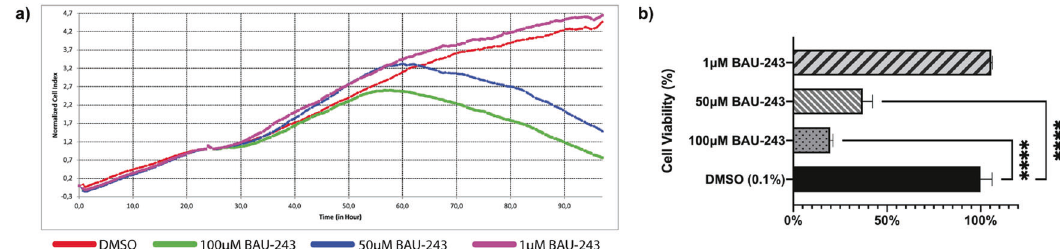
Fig. 1 BAU-243 inhibited GBM cell proliferation. a Normalized cell index of A172 cells treated with DMSO (0.1%), 100 µM, 50 µM, and 1 µM BAU-243. Electrical impedance measurements were taken every 15 min for 96 h. Treatment was done at 24 h after cell seeding. b Percentage cell viability of A172 cells treated with BAU-243. DMSO treated group was accepted as 100%, and cell viability of each condition after treatment at 24, 48, and 72 h were normalized to the DMSO control group. Data are expressed as mean ± SD. Statistical analysis was performed using a two-tailed Student ’ s t -test ( n = 3). * p < 0.05, ** p < 0.01, **** p <